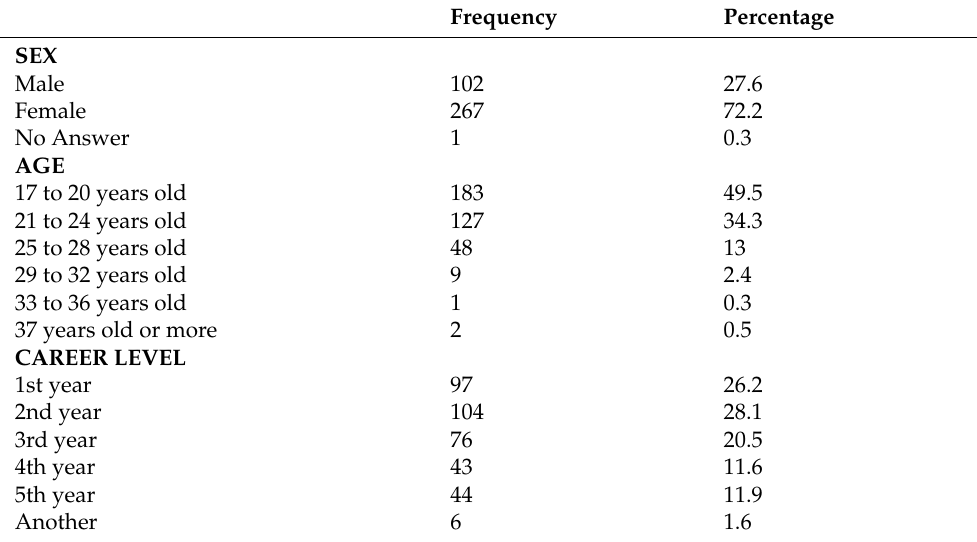
Table 3. Sample Distribution.